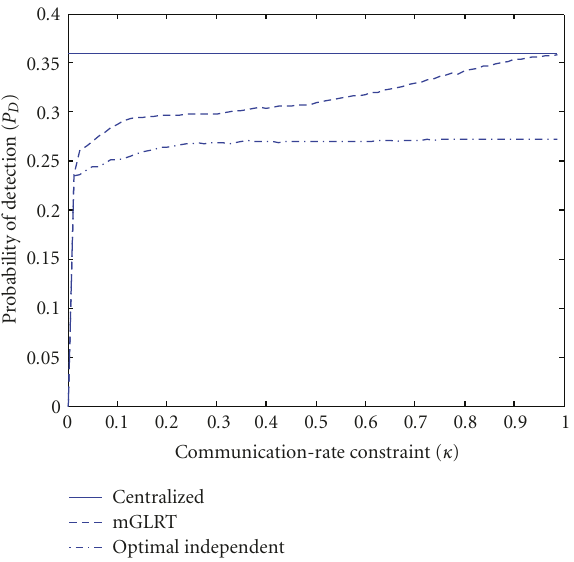
Figure 7: Performance of the mGLRT compared to the optimal independent test as the communication-rate constraint varies with = 5, σ 2 = 3 for P F = 0 . 05 for the eight-sensor example with σ 2 ii ij = 0 . 6 for sensors in di ff erent sets. sensors in the same set, σ 2 ij